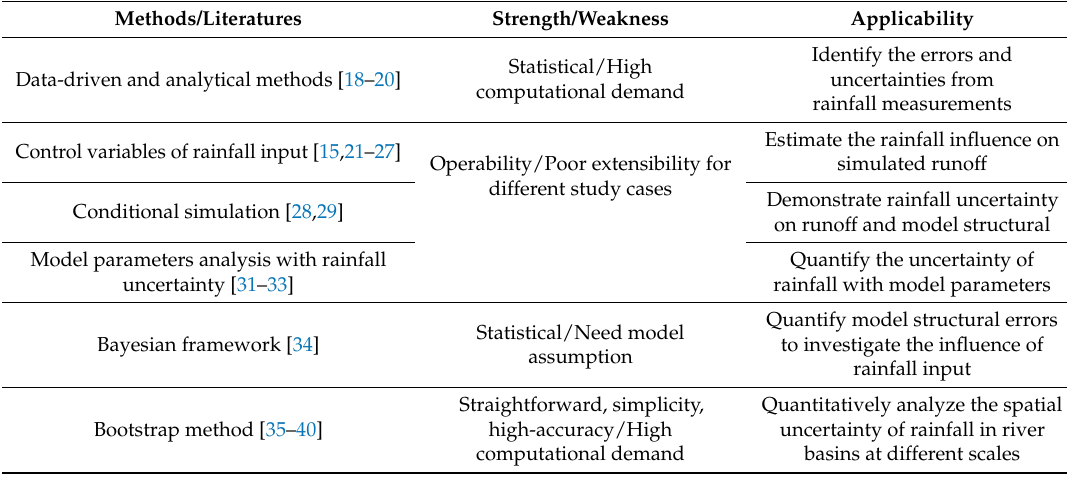
Table 1. Summary of the methods used in hydrological uncertainty estimation from the